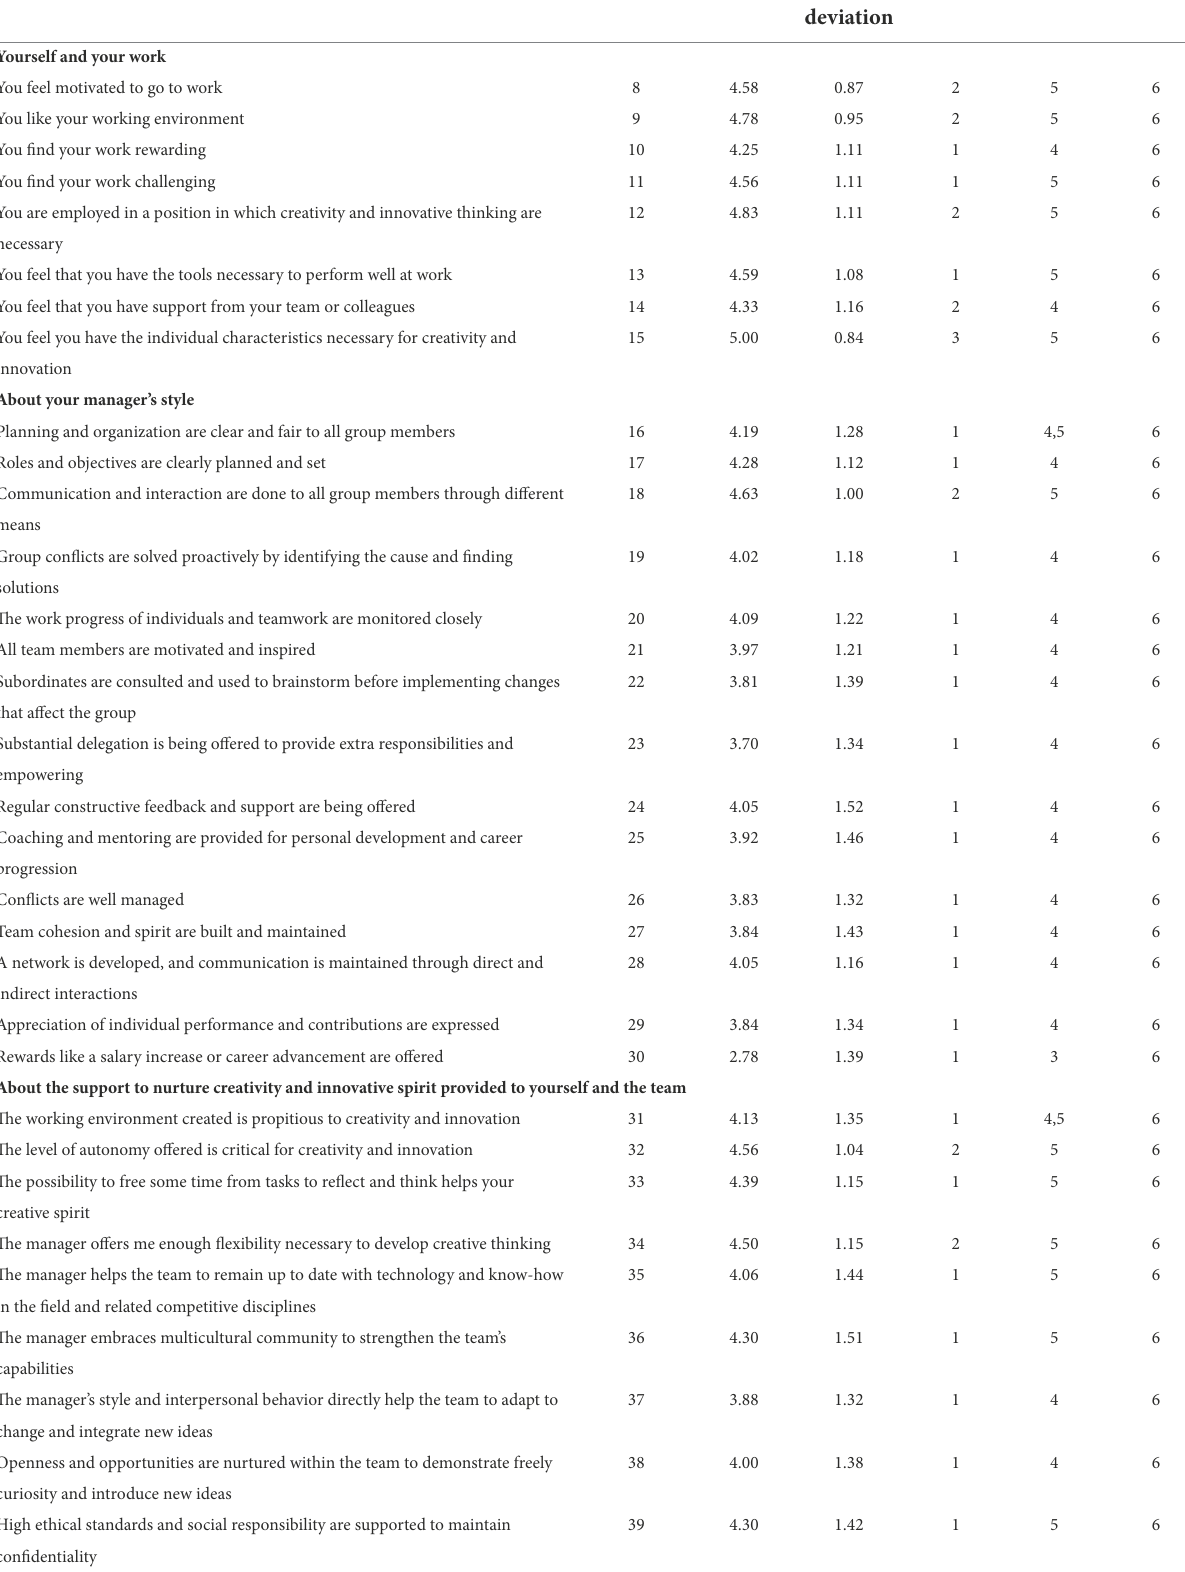
TABLE 1 Summary of statistics indicating the mean, standard deviation, minimum, median, and maximum values of the participants’ responses. Variable Statement Mean Standard